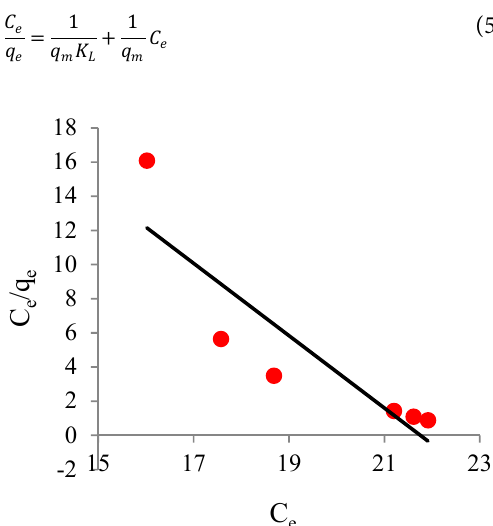
Fig. 9: Langmuir adsorption isotherm of cadmium ions onto polypyrrole/titanium dioxide nanocomposite.